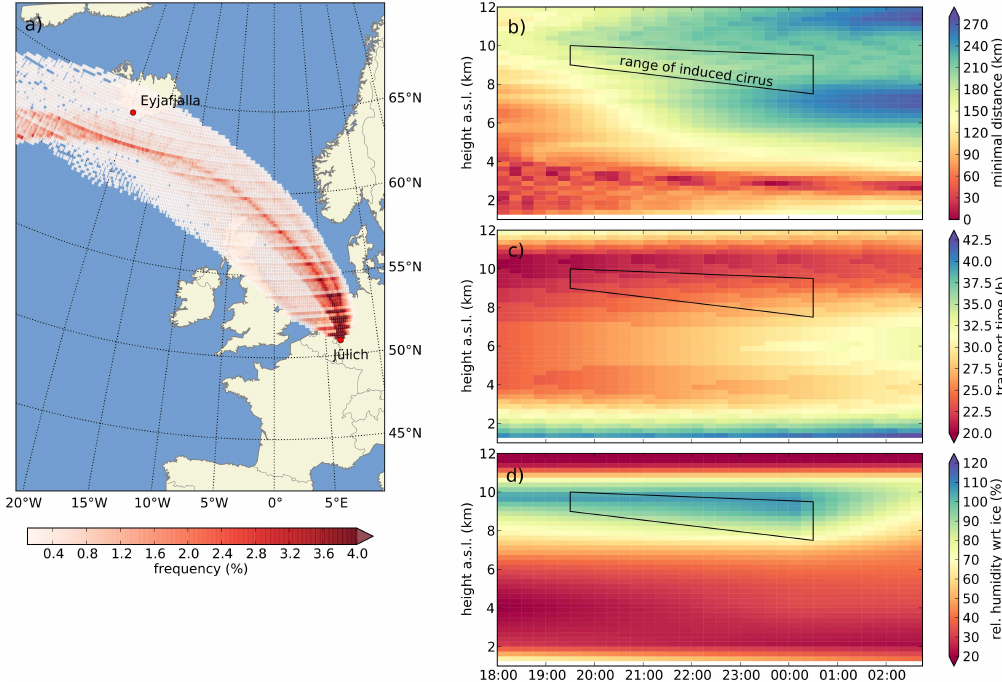
Fig. 2. Backwards trajectories started at a specific time and altitude in J¨ulich and show where the air mass originates: (a) Probability density function of all calculated trajectories, (b) minimal distance of each trajectory to the Eyjafjallaj¨okull volcano, (c) transportation time from minimal distance, and (d) relative humidity with respect to ice at the end of each trajectory over